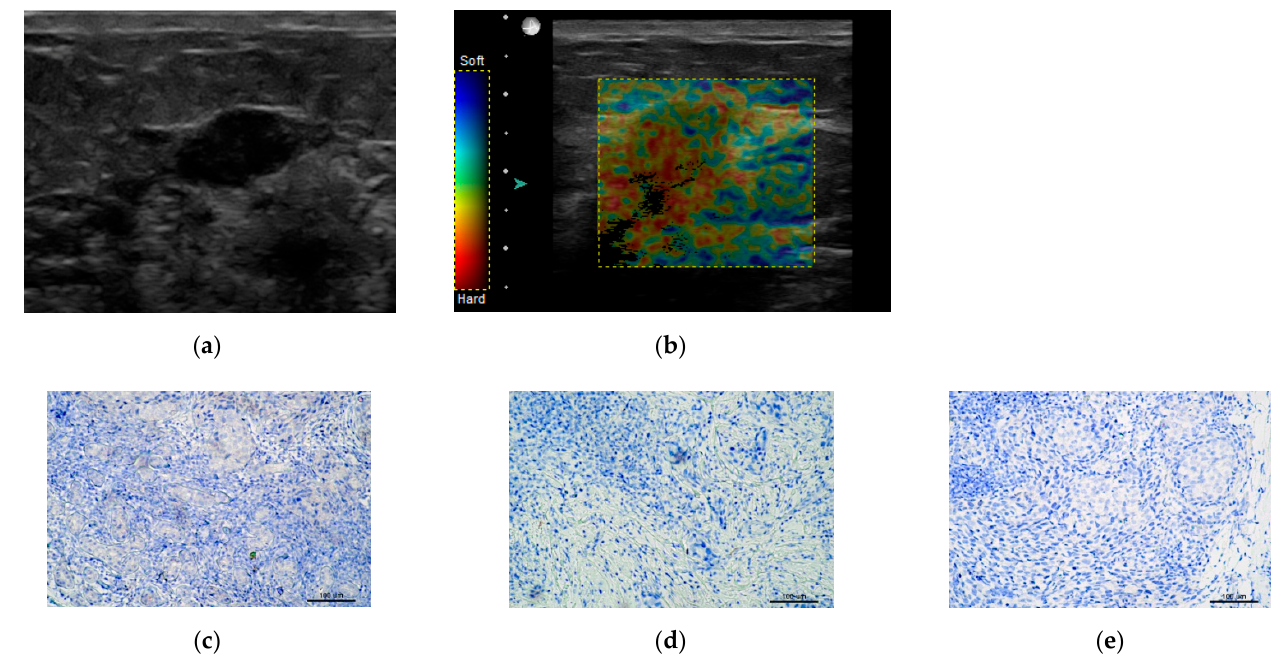
Figure 6. Triple negative breast cancer TNBC ( a ) B-Mode hypoechoic, without calcifications. ( b ) Sonoelastography shows soft tumor Tsukuba2. Lower panel IHC staining: ( c ) HER2 negative, ( d ) PG negative, ( e ) ER negative. IHC = immunohistochemistry, ER = estrogen receptor, PR = progesterone receptor, HER2 = human epidermal growth factor receptor